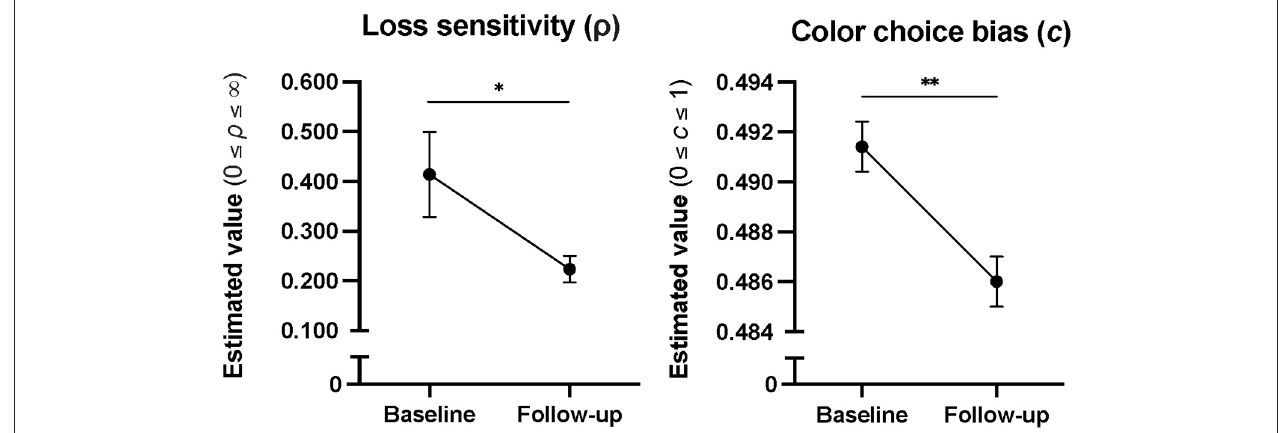
FIGURE 3 | Cumulative model parameter estimates in patients from baseline to 6 months into treatment, showing decreases in Color Choice Bias and Loss Sensitivity over time. Error bars represent standard error. * p < 0.05, and ** p < 0.01.